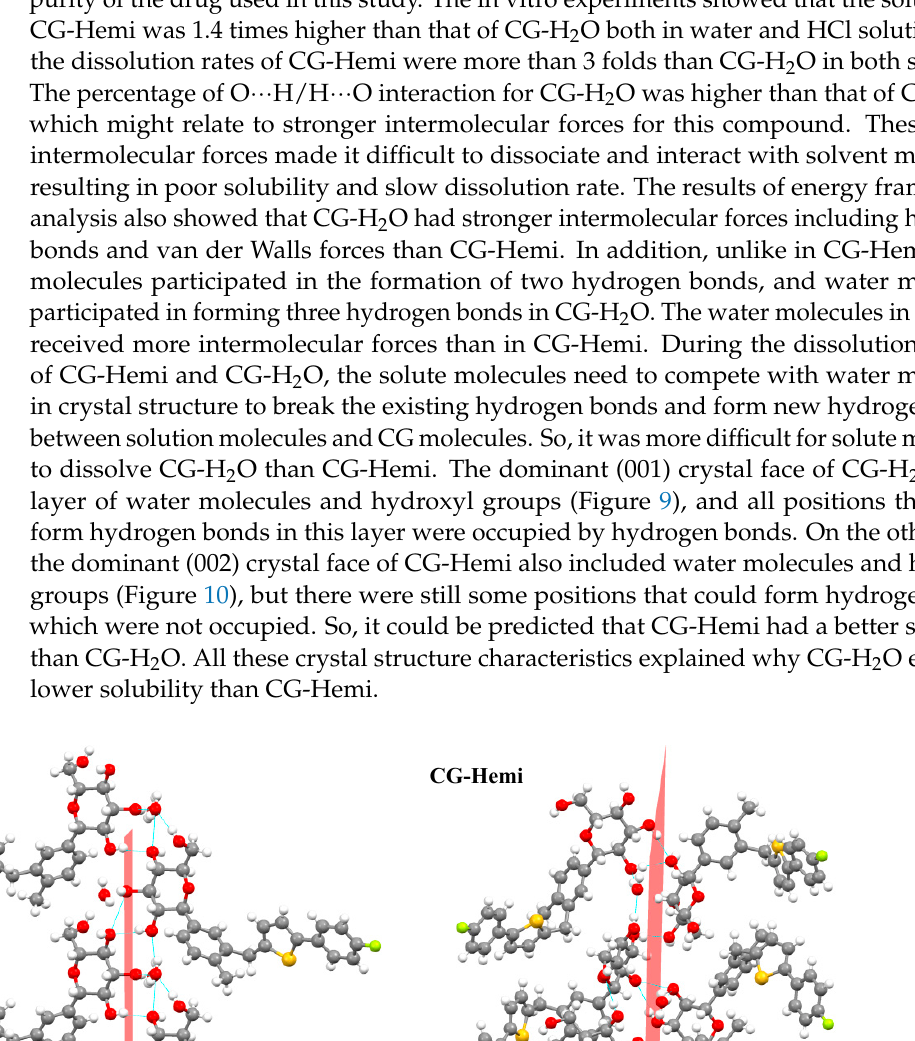
Figure 10. Chemical structure of CG. The chemical name of CG was (1 S )-1,5-anhydro-1-[3-[[5-(4-fluorophenyl)-2-thienyl]methyl]-4-methylphenyl]- D -glucitol. 4. Materials and Methods 4.1. Materials CG-Hemi was provided by Huadong Pharmaceutical Co., Ltd. (Zhejiang, China) and used without further purification. CG-H 2 O was crystallized from mixture solvent of methanol and water by cooling crystallization method. The single crystals of CG-Hemi and CG-H 2 O were prepared by solvent slow evaporation method at ambient humidity and temperature. The chemical structure of CG was shown in Figure 10. 4.2. Single Crystal X-ray Structural Analysis The crystal structures of CG-Hemi and CG-H 2 O were determined by using Rigaku R-AXIS-RAPID X-ray single crystal diffractometer (Rigaku, Tokyo, Japan) equipped with an imaging plate area detector and graphite monochromatic Mo-K α radiation ( λ = 0.71069 Å). Data reduction was performed with Crystal Structure [17]. The crystal structure was solved with direct methods using SHELX-S97 program (Sheldrick, G.M. SHELXS-97, Program for the Solution of Crystal Structures, University of Göttingen, Göttingen, Germany, 1997) and refined anisotropically (non-hydrogen atoms) by